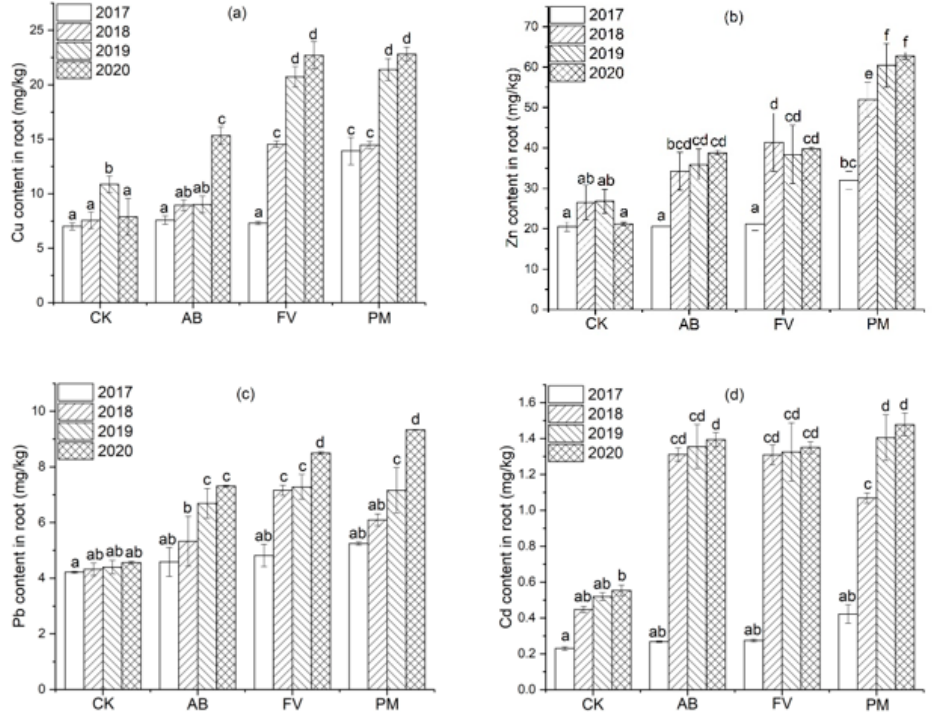
Figure 7. ( a ) Cu content in the rice roots by the different fertilizer treatments during the four experimental years; ( b ) Zn content in the rice roots by the different fertilizer treatments during the four experimental years; ( c ) Pb content in the rice roots by the different fertilizer treatments during the four experimental years; ( d ) Cd content in the rice roots by the different fertilizer treatments during the four experimental years. Data are expressed as means ± SD; n = 3. Different letters on data in the same group indicate a significant difference between them at p < 0.05 level.